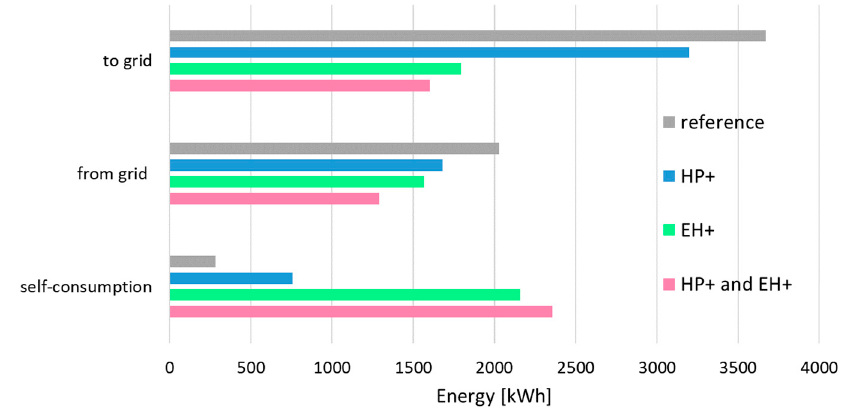
Figure 5. Annual amounts of energy exchanged with grid and self-consumed for the reference case and for the cases with the new control strategies (PV area of 20 m 2 ).